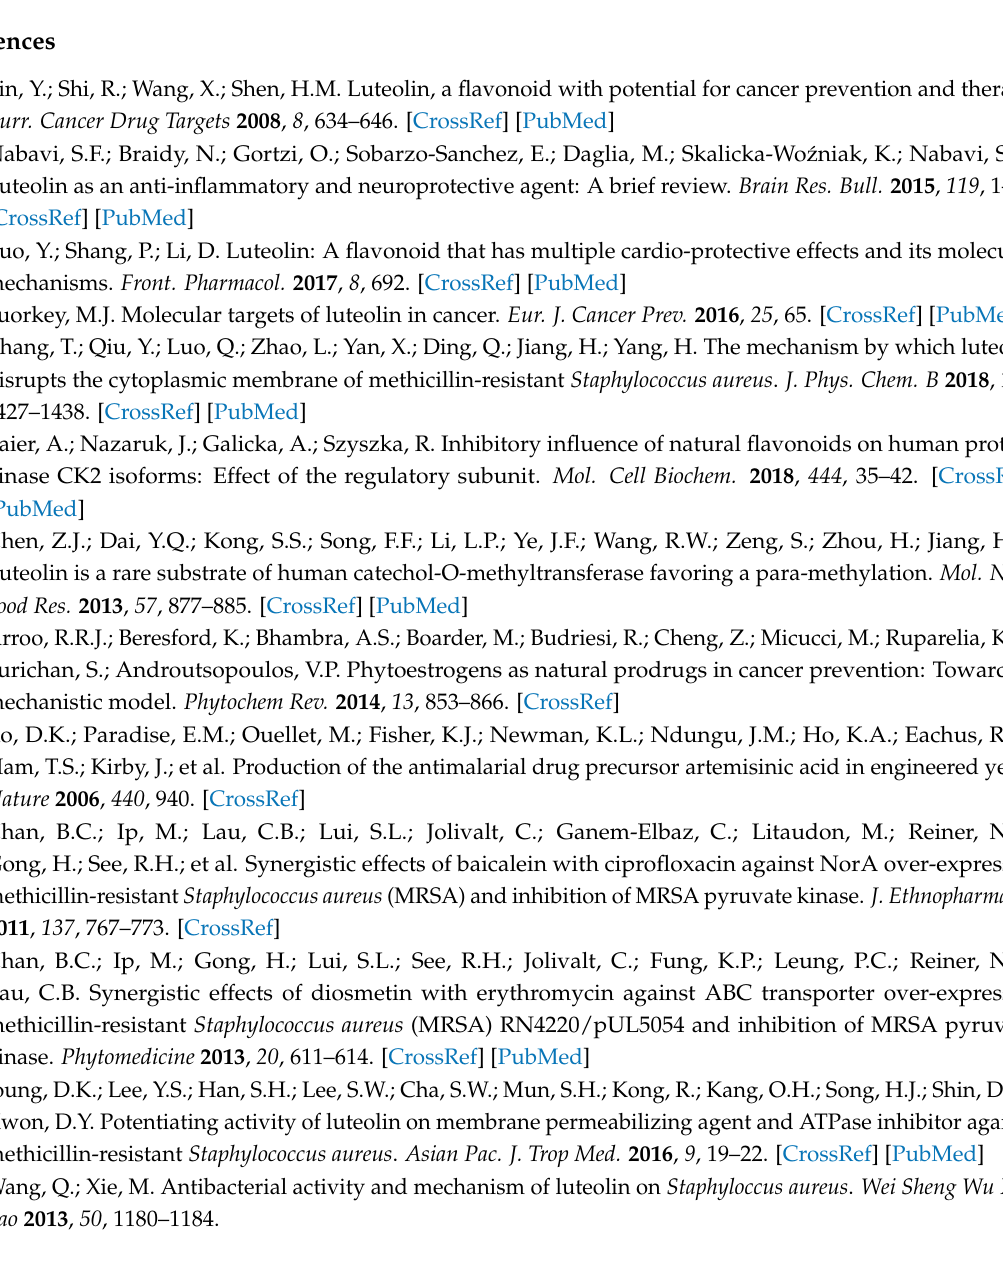
Figure S1. HMBC analysis of chrysoeriol (DMSO- d 6 ,900 MHz); Figure S2. HSQC-DEPT analysis of chrysoeriol (DMSO- d 6 ,900 MHz); and Figure S3. Culture tubes showing inhibition at different concentration: (A) Staphylococcus aureus 3640 (MRSA) (i) chrysoeriol and (ii) luteolin; (B) Proteus hauseri NBRC 3851 (i) chrysoeriol and (ii)